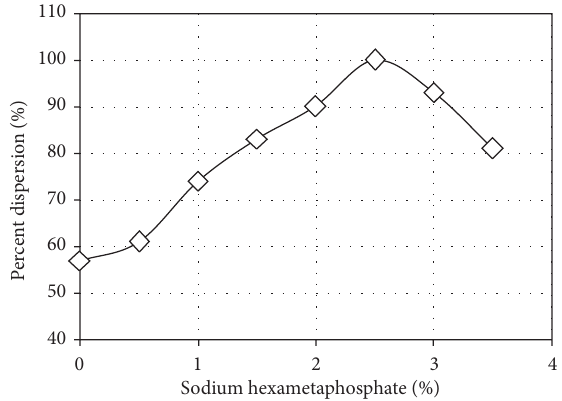
Figure 1: The effect of adding sodium hexametaphosphate on dispersion potential of clay sample from Azerbaijan,